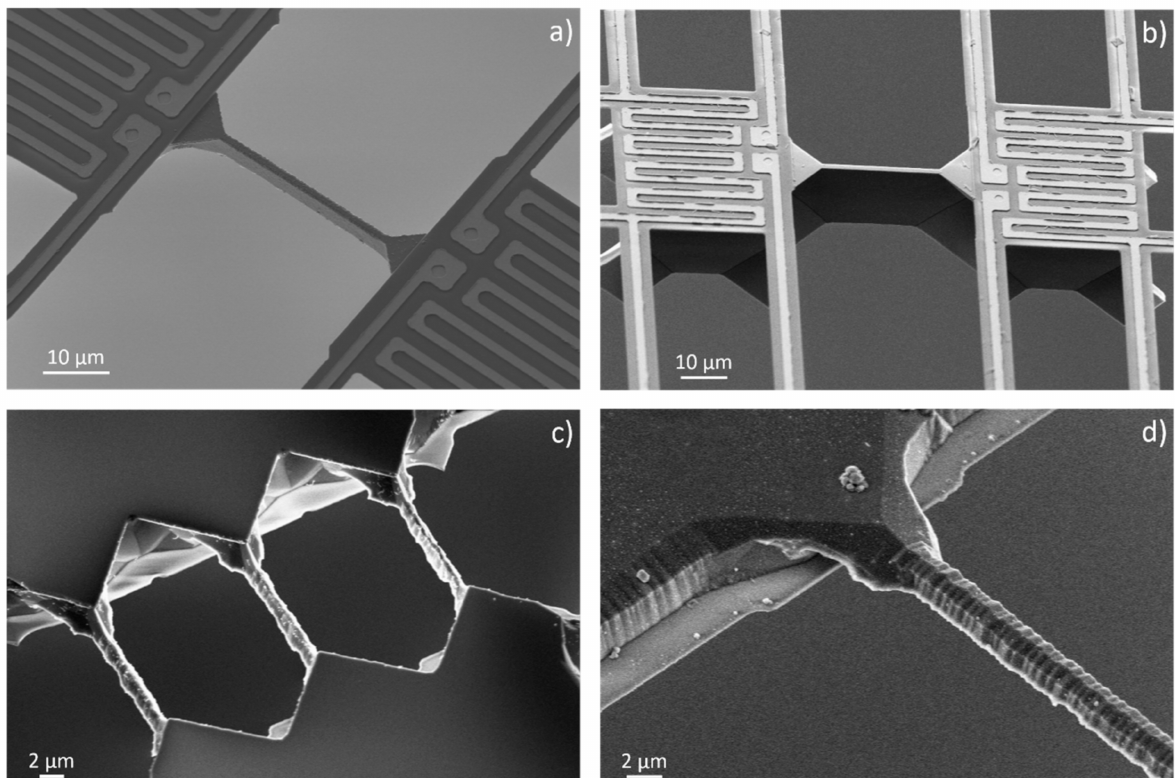
Figure 5. Micro platforms with silicon beams in between are fabricated from single-crystalline bulk ( a , b ) and from SOI ( c , d ) silicon wafers. ( a ) Top view of an n-type silicon device with a height of 4 µ m. ( b ) Top view of an n-type silicon device with a height of 17 µ m. ( c ) Back-side view of a p-type silicon device with three silicon beams in parallel connecting the platforms. ( d ) Back-side view of a p-type silicon beam that is shaped into a rod after wet etch